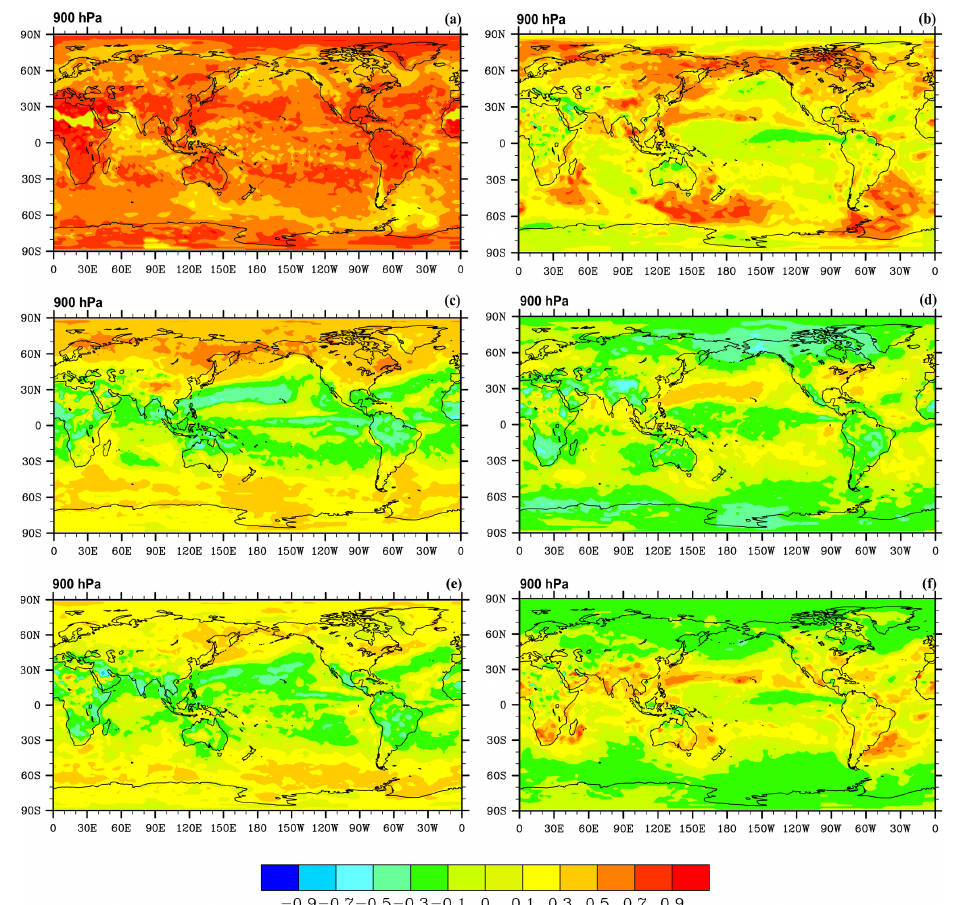
Fig. 2. Distribution of the correlation ( r ) between SOA cld production and (b) LWC, (b) TC loss , (c) temperature, (d) O 3 , (e) OH, (f) VOC/NO x at 900hPa around the